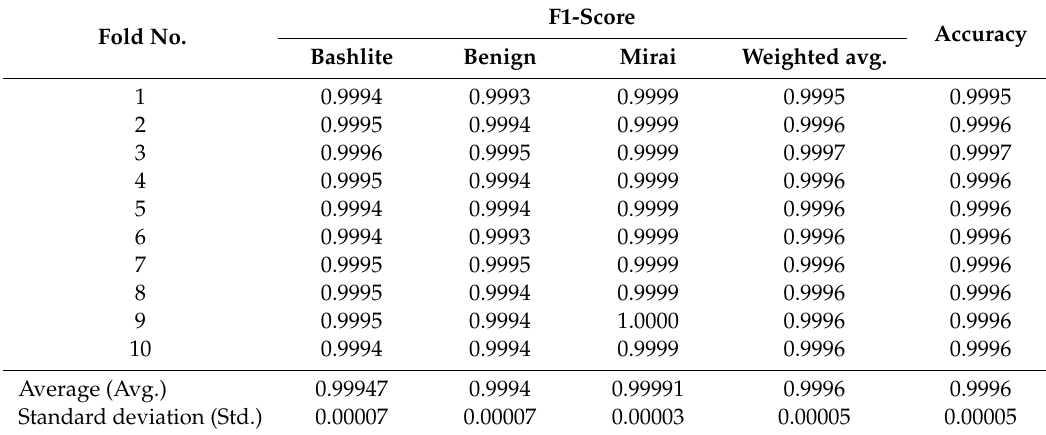
Table 10. F1-scores and accuracy results of the 10-fold cross-validation for Mirai, Bashlite, and benign classifications using the selected feature numbers.